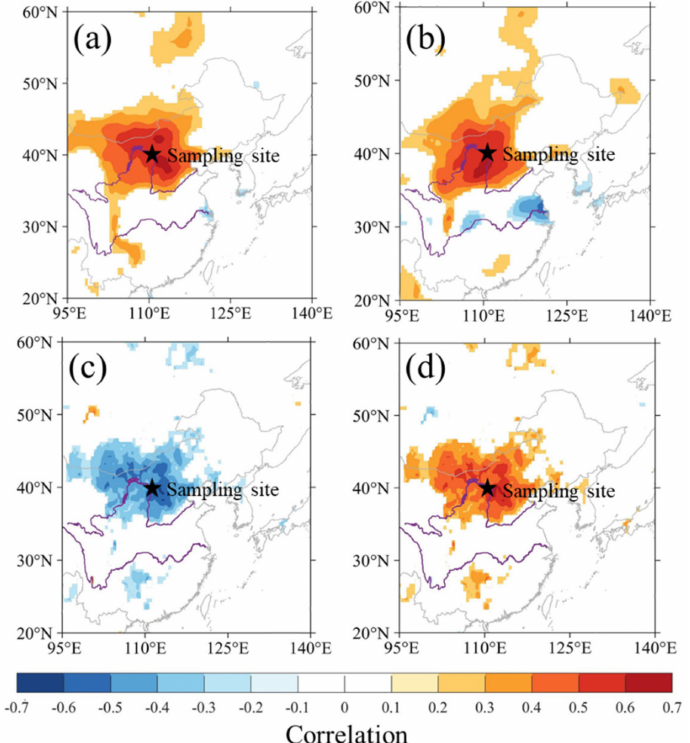
Figure 4. ( a ) Spatial correlation between precipitation and reconstruction VP JA during 1957–2012. ( b ) Spatial correlation between precipitation and the mean values of VP JA observed at two meteoro- logical stations near the sampling site (Yulin and Baotou meteorological stations) during 1957–2012. ( c ) Spatial correlation between tree ring δ 18 O and the PDSI drought index during 1901–2012. ( d ) Spa- tial correlation between reconstruction VP JA and the PDSI drought index during